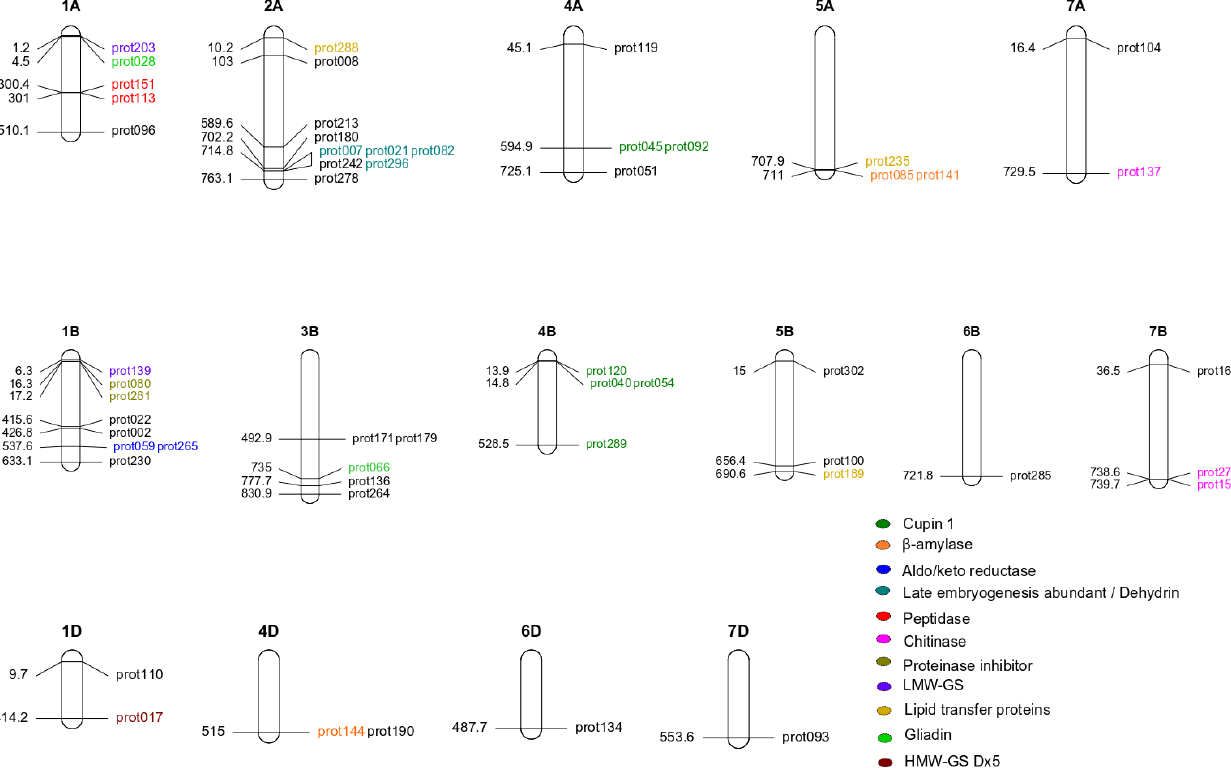
Figure 3. Chromosome map showing the distribution of 54 QTLs with their respective protein name and physical position (Mbp). For a detailed investigation of wheat flour proteins, we focused on the eleven proteins associated with gluten and potential allergenicity based on UniProt and InterPro databases (Table 1). Five of the seven gluten proteins were also present in the Allergome database (https://allergome.org/, accessed on 16 February 2021). We assigned these eleven proteins to the following groups: gluten, gluten and allergen, and non-gluten allergen. Using the UniProt database, we were able to name eight of these eleven proteins, including proteins important for baking quality such as HMW-GS Dx5 and LMW Glu-A3 . QTLs for two lipid transfer proteins could be identified,